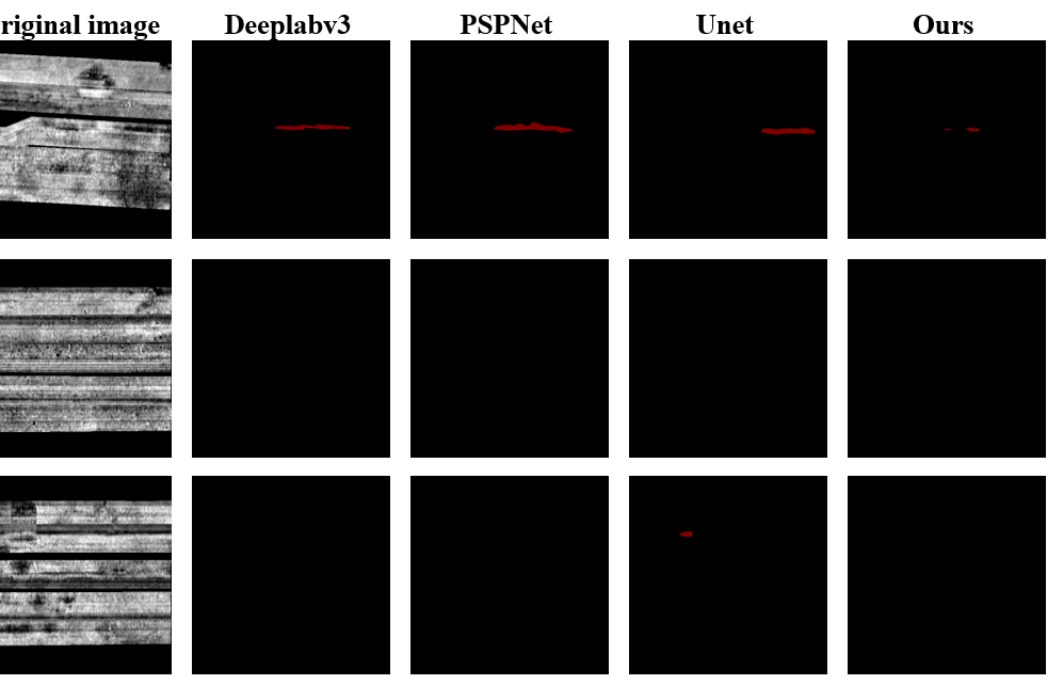
Figure 15. Segmentation results from non-crack data set.